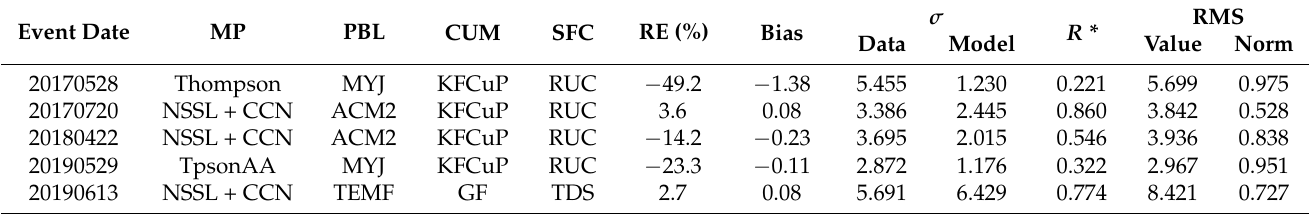
Table 3. The best settings and their respective statistical metrics.